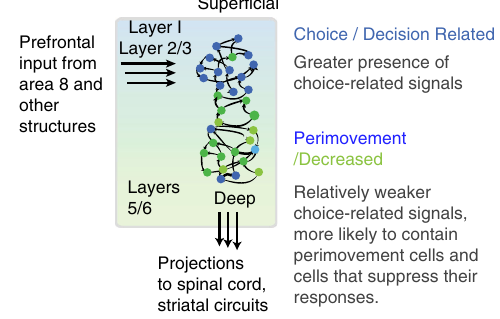
Fig. 5 A schematic architecture for decision-making in PMd. The super fi cial layers of PMd are thought to receive inputs from prefrontal and prearcuate areas. The deeper layers of PMd are thought to project to subcortical and spinal circuits. Differences in anatomical connectivity is one hypothesis for why choice-related activity emerges earlier in the super fi cial compared to the deeper